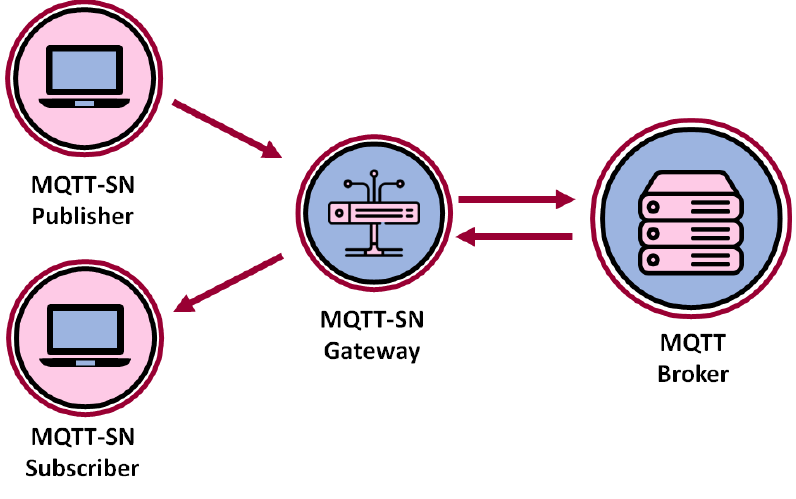
Figure 1. Sketch of the MQTT-SN